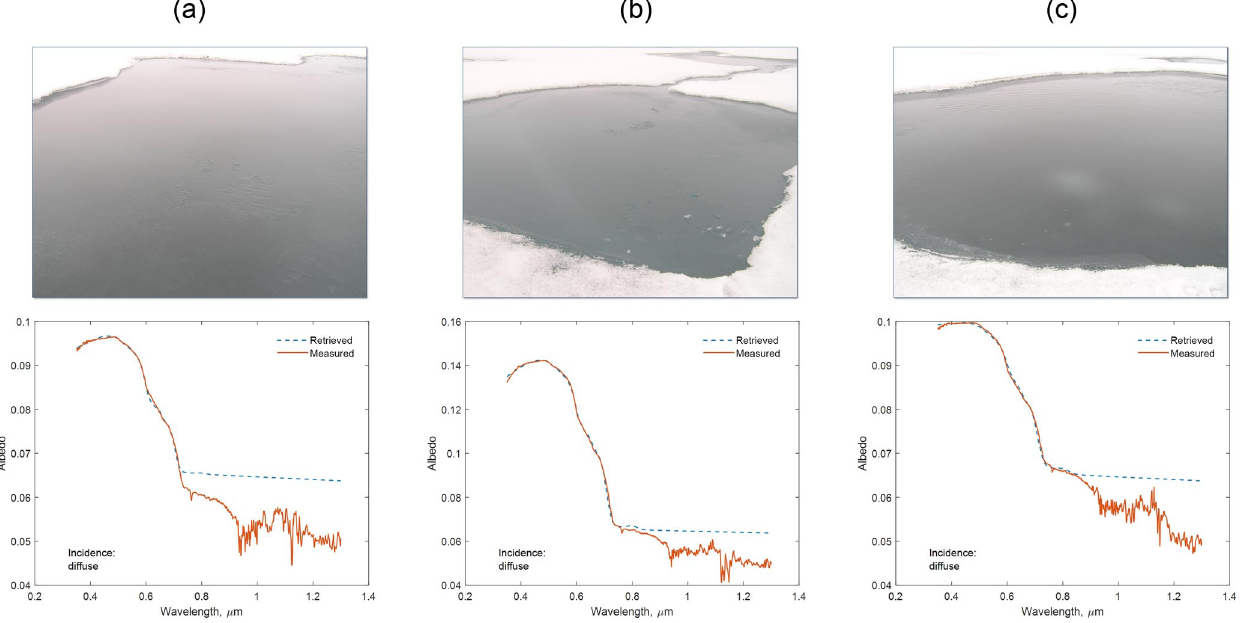
Figure 8. Dark open ponds. Polarstern-2012, Stations